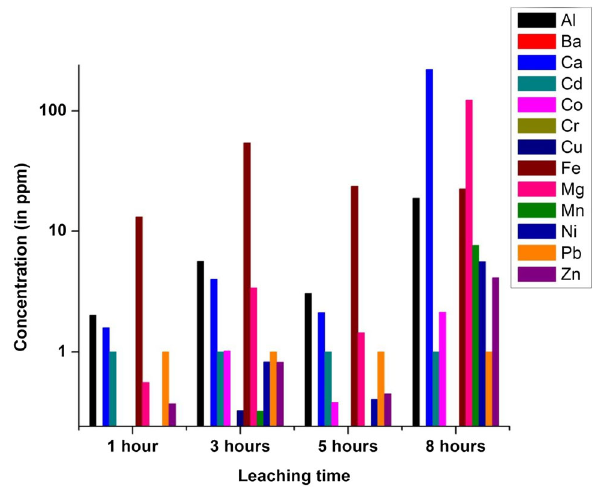
Fig. 25 Change in elemental concentration (in ppm) in aqueous leachates of Ledo coal (LC-20A) with leaching time (in hour) at 45 (cid:3) C